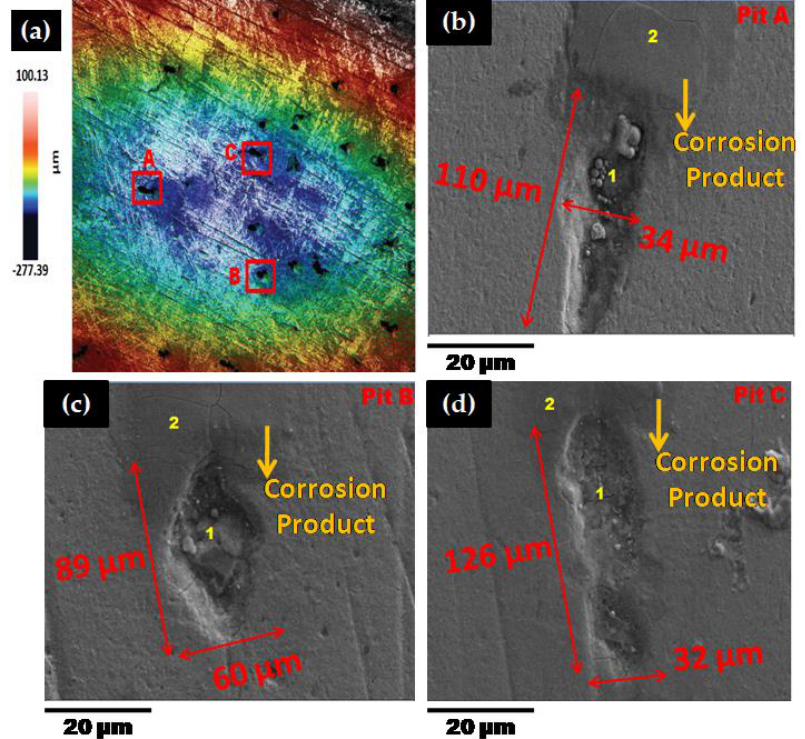
Figure 10. Micrographs of 90 ◦ elbow exit section for 5 wt.% sand fines concentration ( a ) confocal ( b – d ) SEM inside pit (1) and outside pit (2).